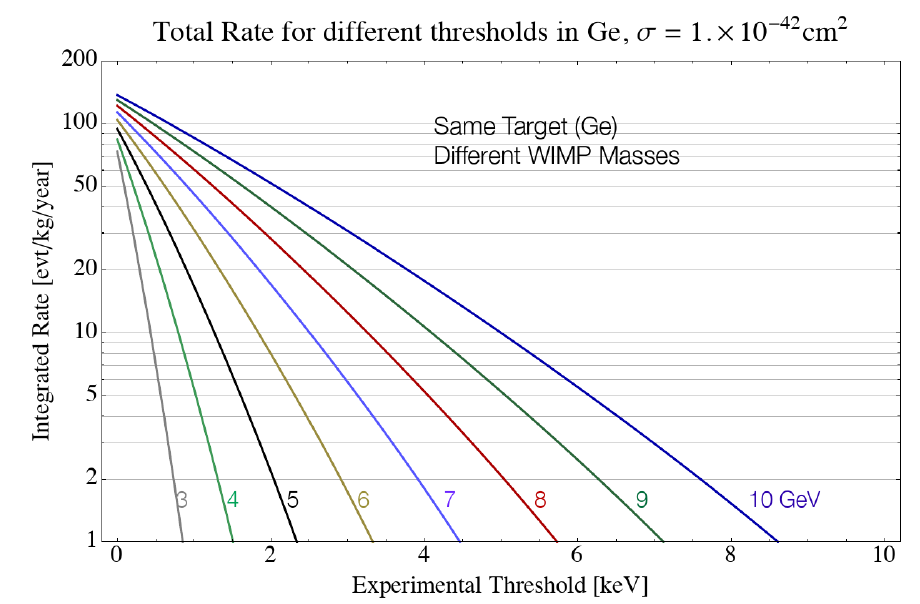
Figure 8: Event rates in units of counts per kg of material per year of data-taking vs. energy threshold (in keV) for different low WIMP masses. The target material is fixed on Germanium. Figure courtesy of Enectali Figueroa-Feliciano.